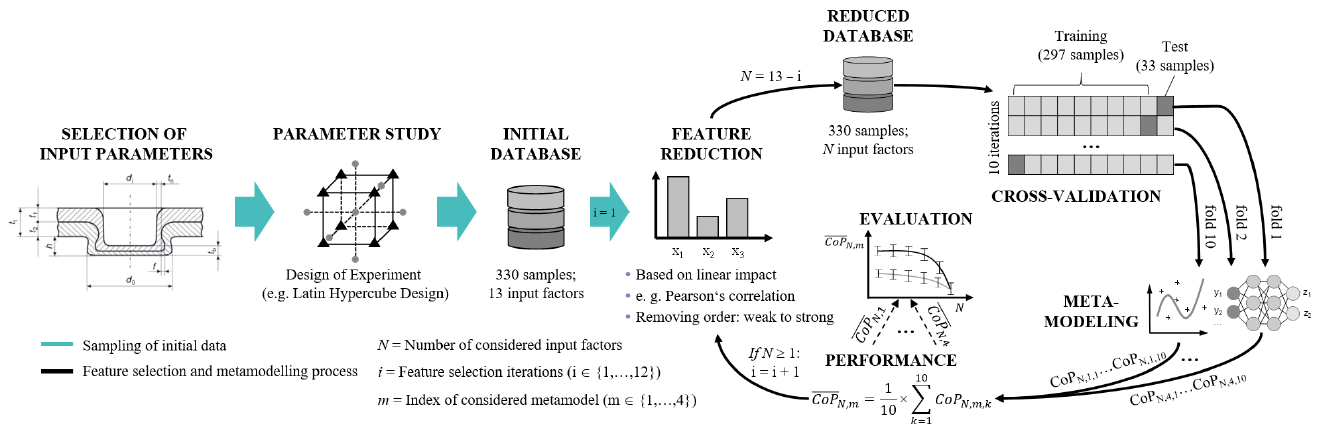
Figure 1. Illustration of the applied general approach.